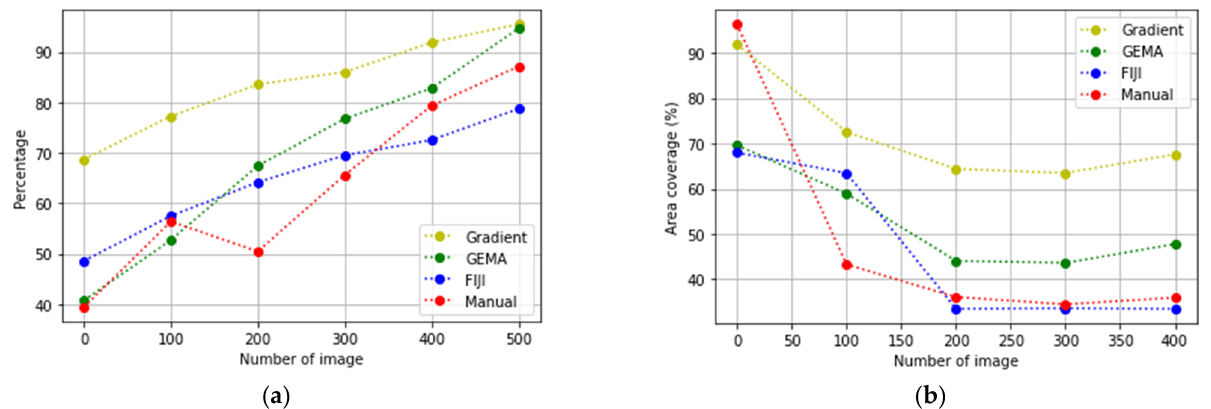
Figure 11. Results from Dataset_2 ( a ) The evolution to confluency stage; ( b ) the evolution to apoptosis stage.